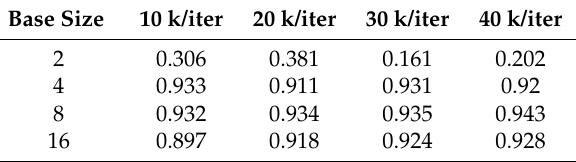
Table 3. Detection performance at each stage.